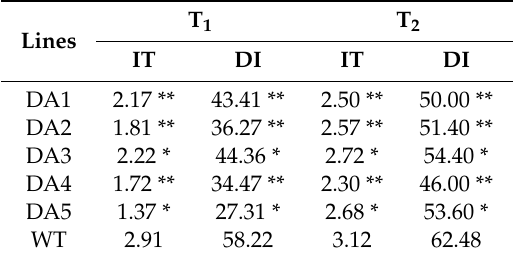
Table 1. Responses of DmAMP1W transgenic wheat lines to sharp eyespot.